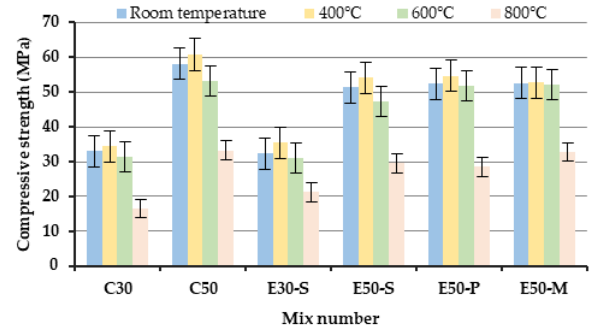
Figure 4. Results of compressive strength test.